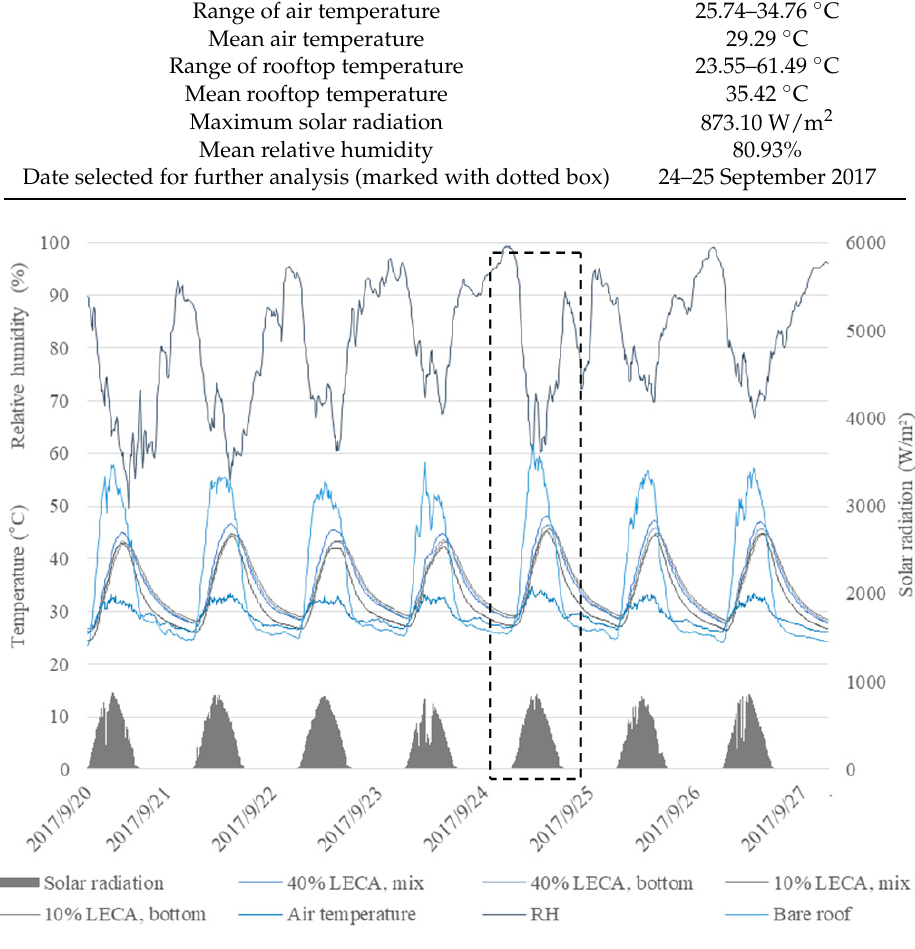
Figure 13. Temperatures, solar radiation, and relative humidity in the cases of roofs with 10% and 40% LECA laid at the bottom without plants, and of 10% and 40% LECA mixed with the soil without